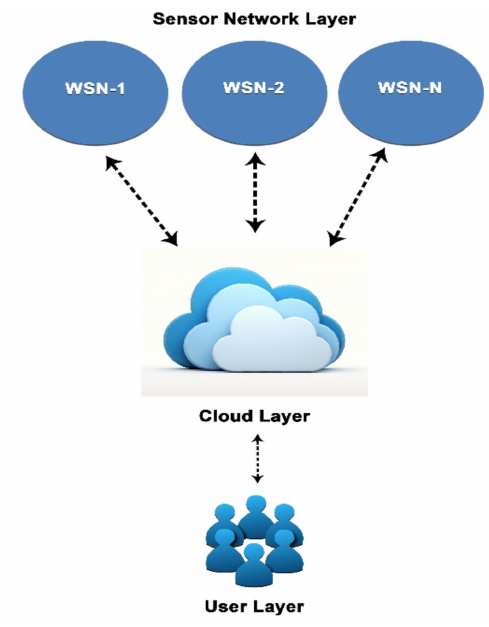
Figure 1. WSN to cloud